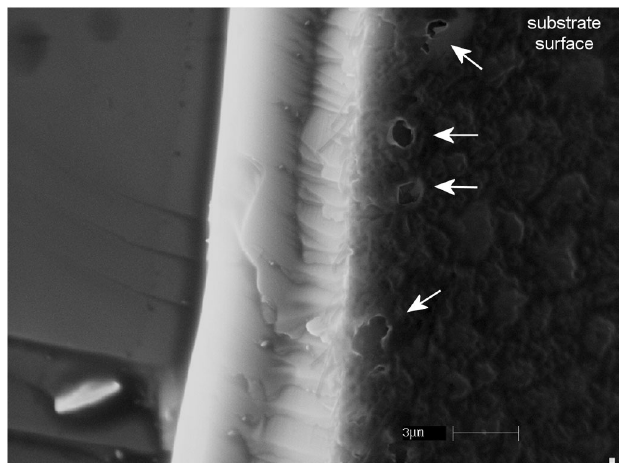
FIG. 14. SEM micrograph of the substrate cross section, be- neath the damage site. The surface of the substrate is towards the right. Pore structures are indicated by